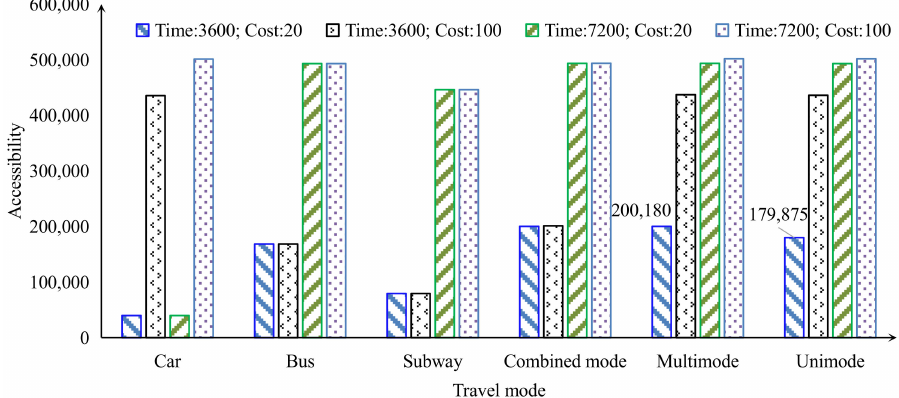
Figure 10. Accessibility at different times and